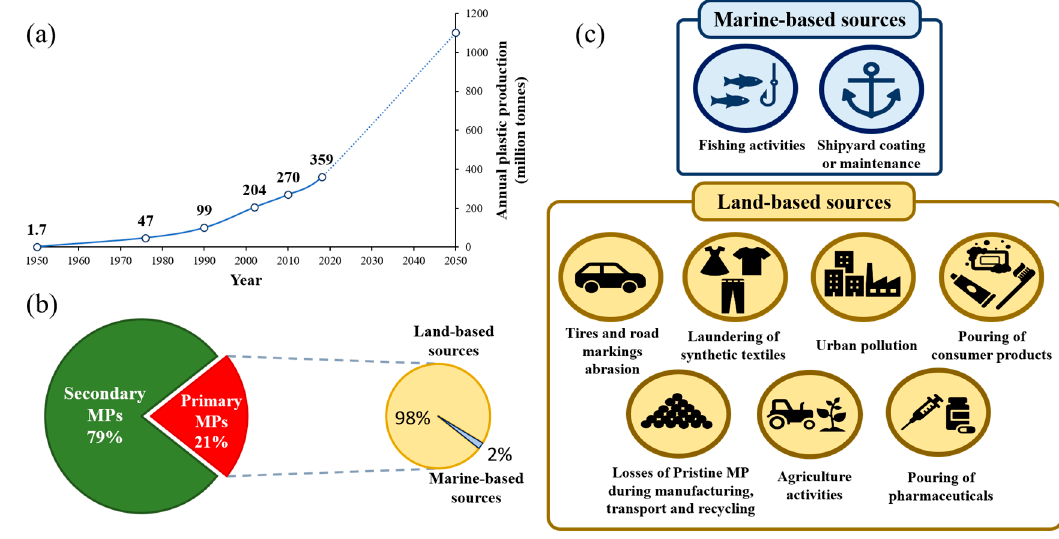
Figure 1. ( a ) Global plastic production since the 1950s together with an estimate of the global plastic production until 2050. ( b ) Estimated percentage of primary microplastics (MPs) that ends up into oceans respect the total MPs materials released into marine ecosystems every year. The percentage of land-based and marine-based contributions are also presented. ( c ) Most important land-based and marine-based sources of primary MPs released into marine ecosystems.